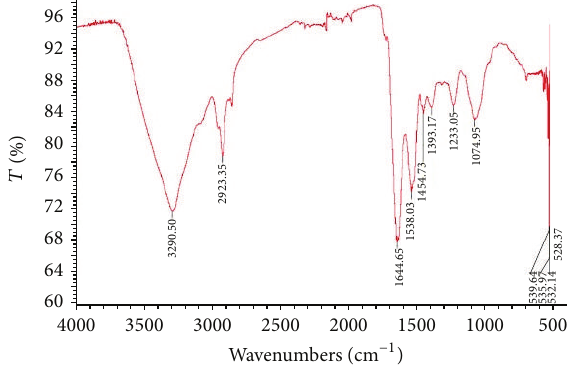
Figure 9: FTIR spectrum showing the presence of proteins as cap- ping agents for AgNps synthesized by endophytic fungi, Penicillium sp .